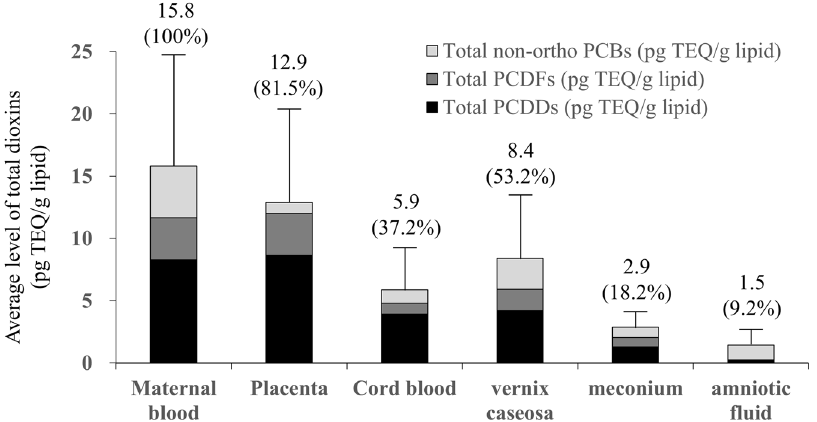
Figure 1. Average levels and SDs of total dioxins. Values in brackets indicate the proportion relative to maternal blood, which was set as 100%. TEQ, Toxic equivalent quantity; SD, standard